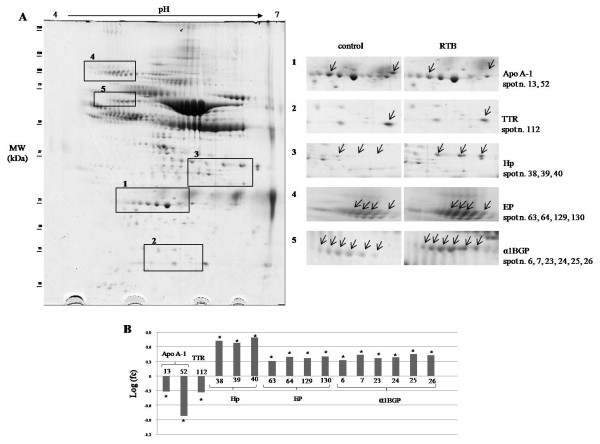
Differential 2-DE analysis of serum in sheep with RTB. A) 2-DE serum sheep map and expanded view of the gel portions including the deregulated proteins. Spot proteins differing by > 2 fold (P < 0.05) in sheep with RTB compared to healthy sheep (control) were indicated. Area 1: spots identified as Apo A-1; Area 2: spots identified as TTR; Area 3: spots identified as Hp; Area 4: spots identified as EP; Area 5: spots identified as α1BGP. B) Histograms representing log fold change (calculated as a ratio of average density spots in RTB vs average density spots in healthy controls). *: Spots with fold change more than 2 or less than 0.5 with statistically significant P < 0.05.